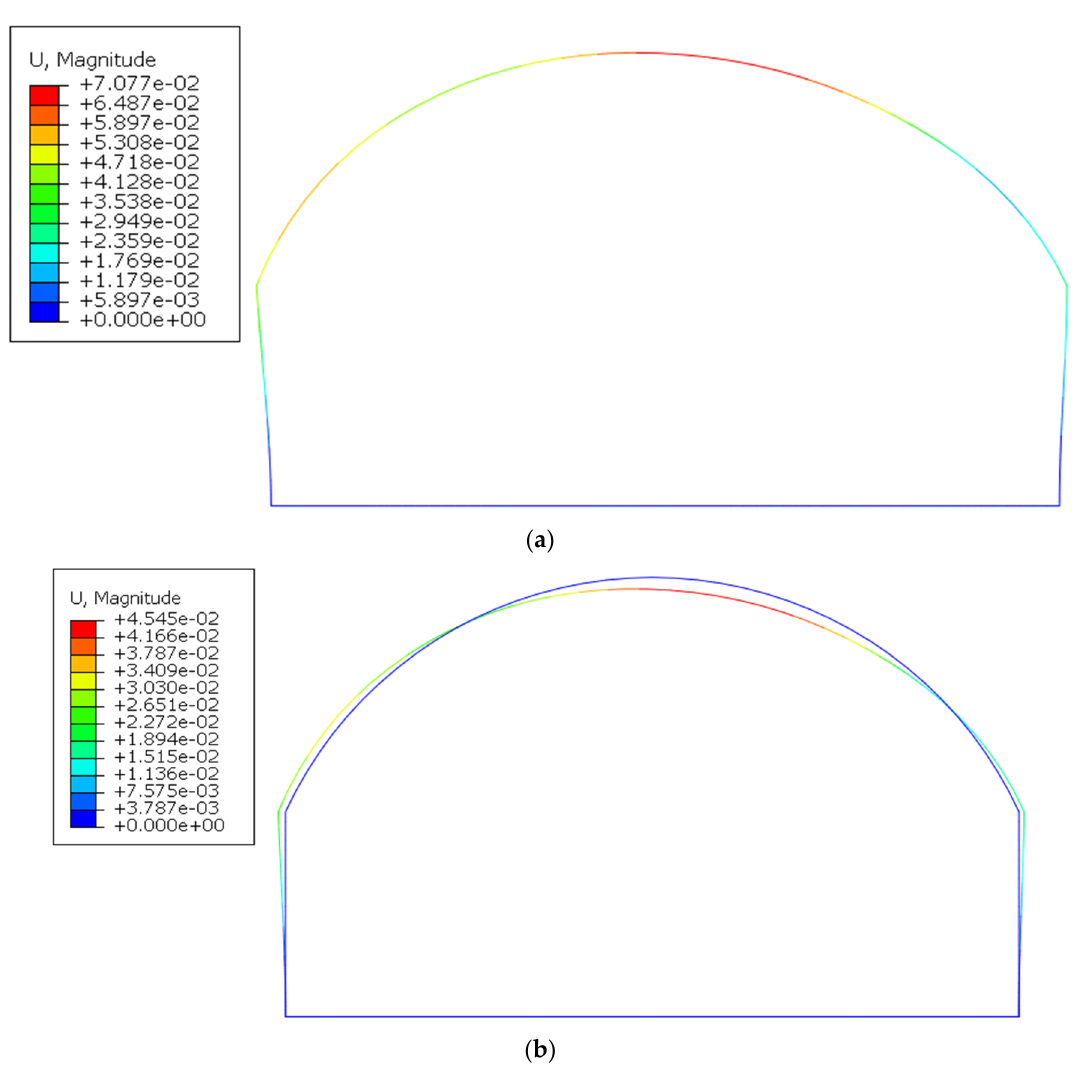
Figure 15. Simulation results of deformations (mm). ( a ) No side wall; ( b ) Side wall.